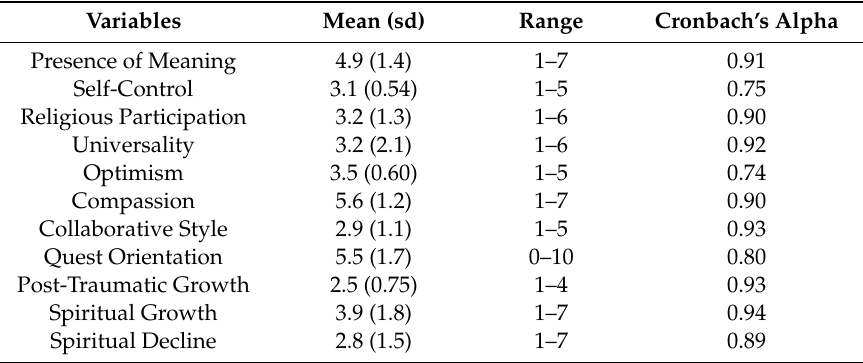
Table 1. Descriptive Statistics on all Primary